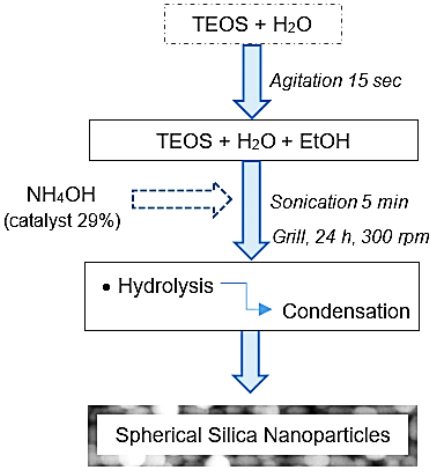
Figure 2. Flow chart for the synthesis of silica nanoparticles by the sol-gel method.